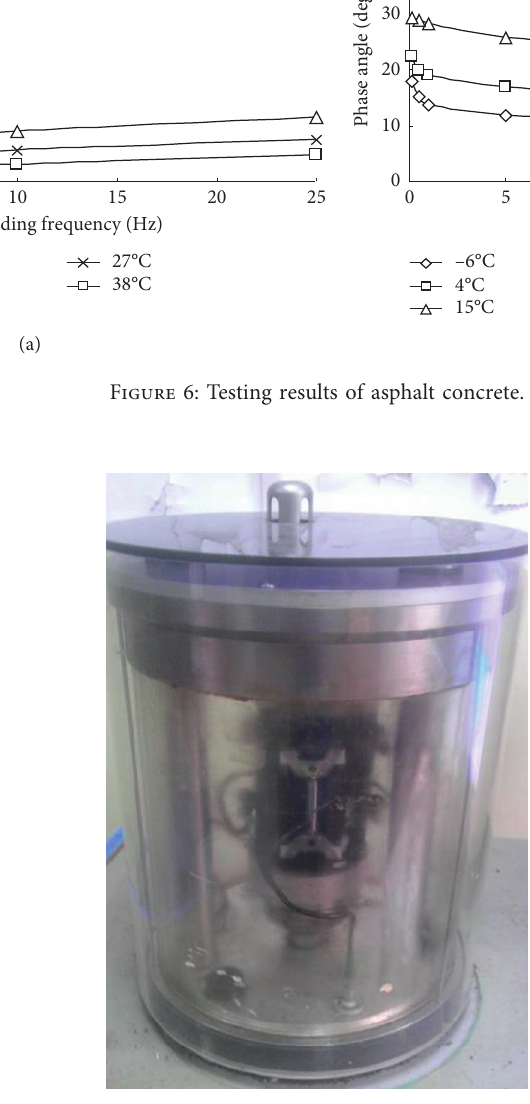
Figure 7: Schematic of the dynamic modulus